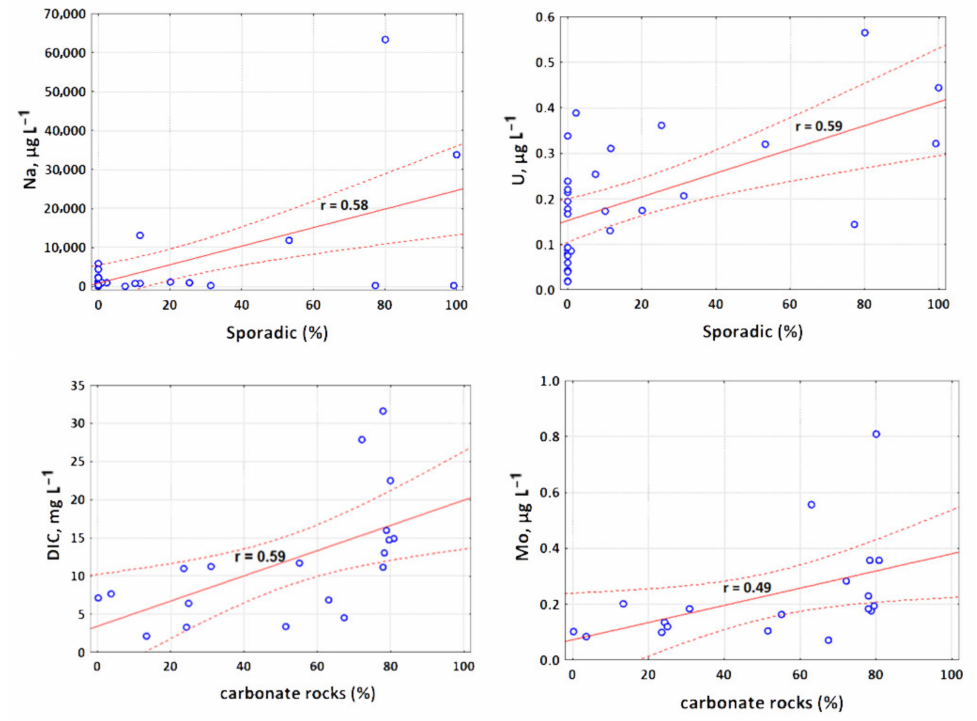
Figure 6. Significant ( p < 0.05) positive control of permafrost distribution—percentage of sporadic permafrost coverage (Na and U) and lithology of rocks—percentage of carbonate rocks (DIC, Mo) on element concentration in the Lena River